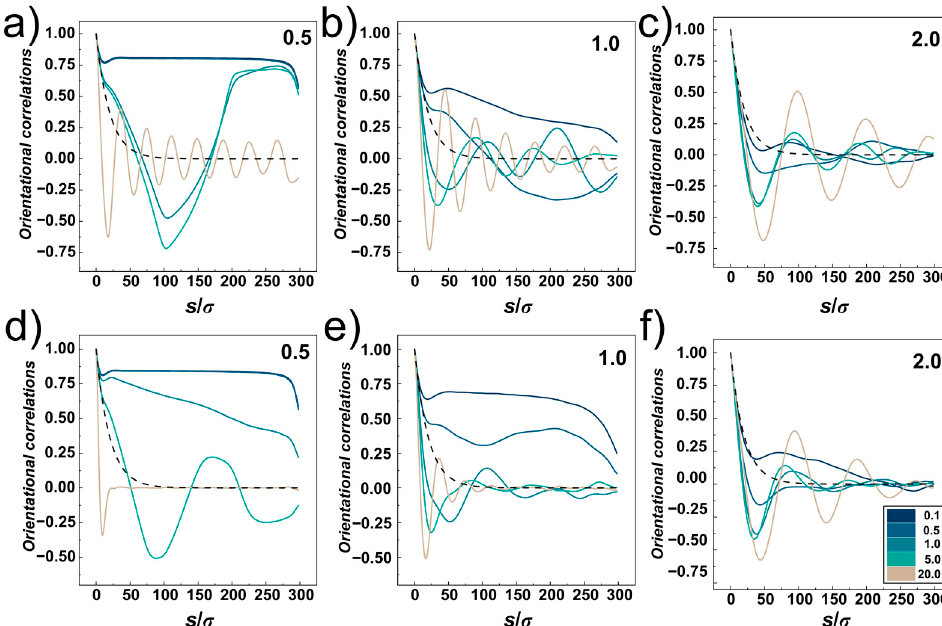
Figure 8. Orientational correlations as a function of the channel geometry, confinement strength and compressive force. Panels ( a – c ) show orientational correlations for cylindrical channels, and panels ( d – f ) show the orientational correlations obtained as average for right-handed and left-handed helical channels. The investigated range of confinement strengths D / P = 0.5, 1.0 and 2.0 is indicated by numbers in the upper right corner of the plots. The data are shown for compressive force F σ / ε 0 = 0.1, 0.5, 1, 5 and 20 indicated by the color-scale legend. The dashed line corresponds to the orientational correlations decay in the bulk, given as <cos θ > = exp ( − s / P ), where s is the coordinate along the chain.